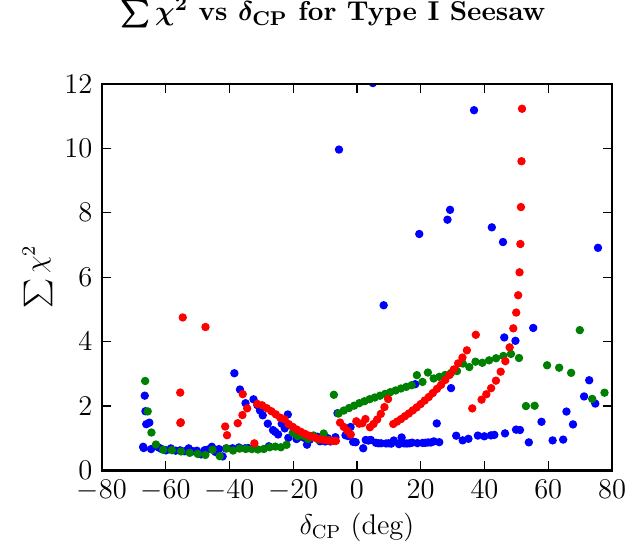
Figure 3 . Comparisons of the Dirac CP phase angle to sum of chi squares for the model in the type-I seesaw case. Each color represents results for a di(cid:11)erent set of initial values for the input